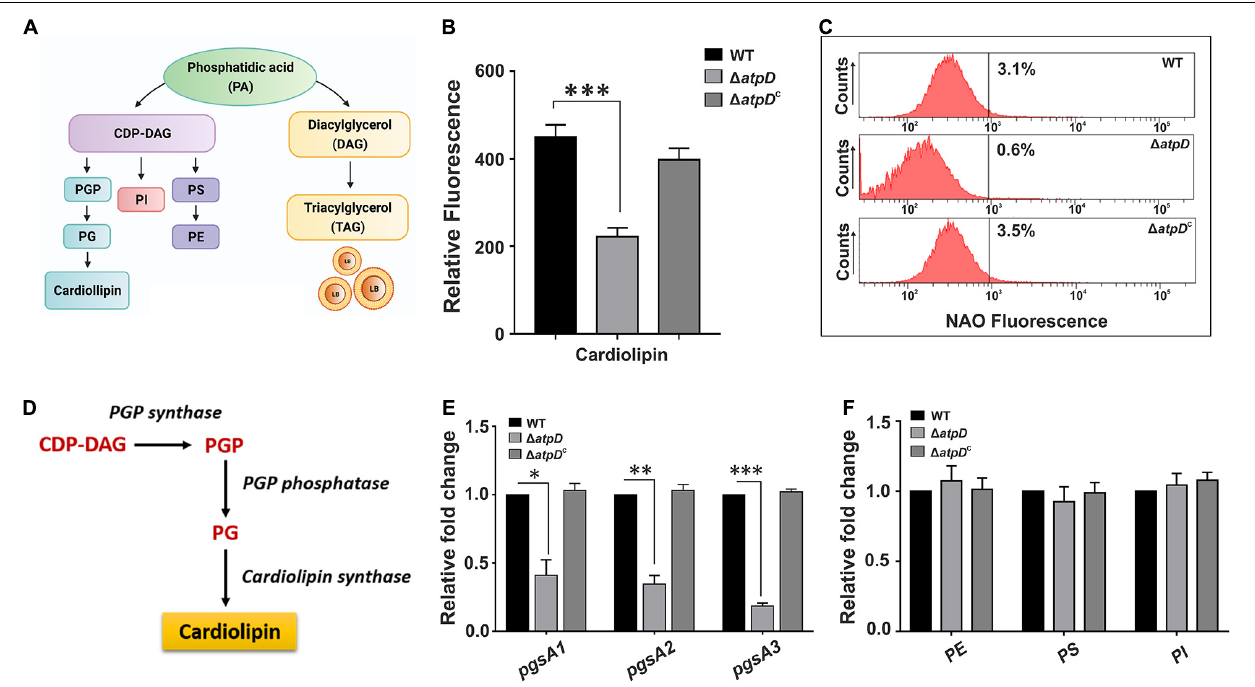
FIGURE 3 | Mycobacterium smegmatis (cid:49) atpD shows reduced cardiolipin content. Panel (A) shows various mycobacterial membrane lipids along with the flow of key phospholipid biosynthesis pathways. PGP, phosphatidylglycerol phosphate; PG, phosphatidylglycerol; PI, phosphatidylinositol; PS, phosphatidylserine; PE, phosphatidylethanolamine; CDP-DAG, cytidine-diphosphate diacylglycerol. Panel (B) shows the Nonyl Acridine orange (NAO) dye fluorescence measured for M. smegmatis wild-type (WT), atpD knock-out ( (cid:49) atpD ), and atpD -complemented ( (cid:49) atpD C ) strains. Panel (C) shows the flow cytometric analysis of all the three strains after staining the cells with NAO dye. The percentage value represents the fraction of cells that are positive for that fluorescence. Flow cytometry experiments were repeated at least thrice; the graph shows only one representative data. Panel (D) shows the cardiolipin biosynthesis pathway in mycobacteria. Panel (E) shows the gene expression analysis for plasma membrane biosynthesis genes pgsA1, pgsA2 , and pgsA3 by RT-qPCR in M. smegmatis wild-type, (cid:49) atpD , and (cid:49) atpD C strains. Panel (F) shows the relative expression level of major structural genes – MSMEG_6851 (phosphatidylethanolamine or PE), MSMEG_0860 (phosphatidylserine or PS), and MSMEG_2933 (phosphatidylinositol or PI) in M. smegmatis wild-type, (cid:49) atpD , and (cid:49) atpD C strains. In both panels (E,F) , the transcript level in each case is compared with that of M. smegmatis WT, which is taken as 1. In panels (B,E,F) , data represent an average of at least three independent experiments with standard deviation shown as error bars. ∗ P -value < 0.05; ∗∗ P -value < 0.01; ∗∗∗ P -value < 0.005. Panel (A) is created with